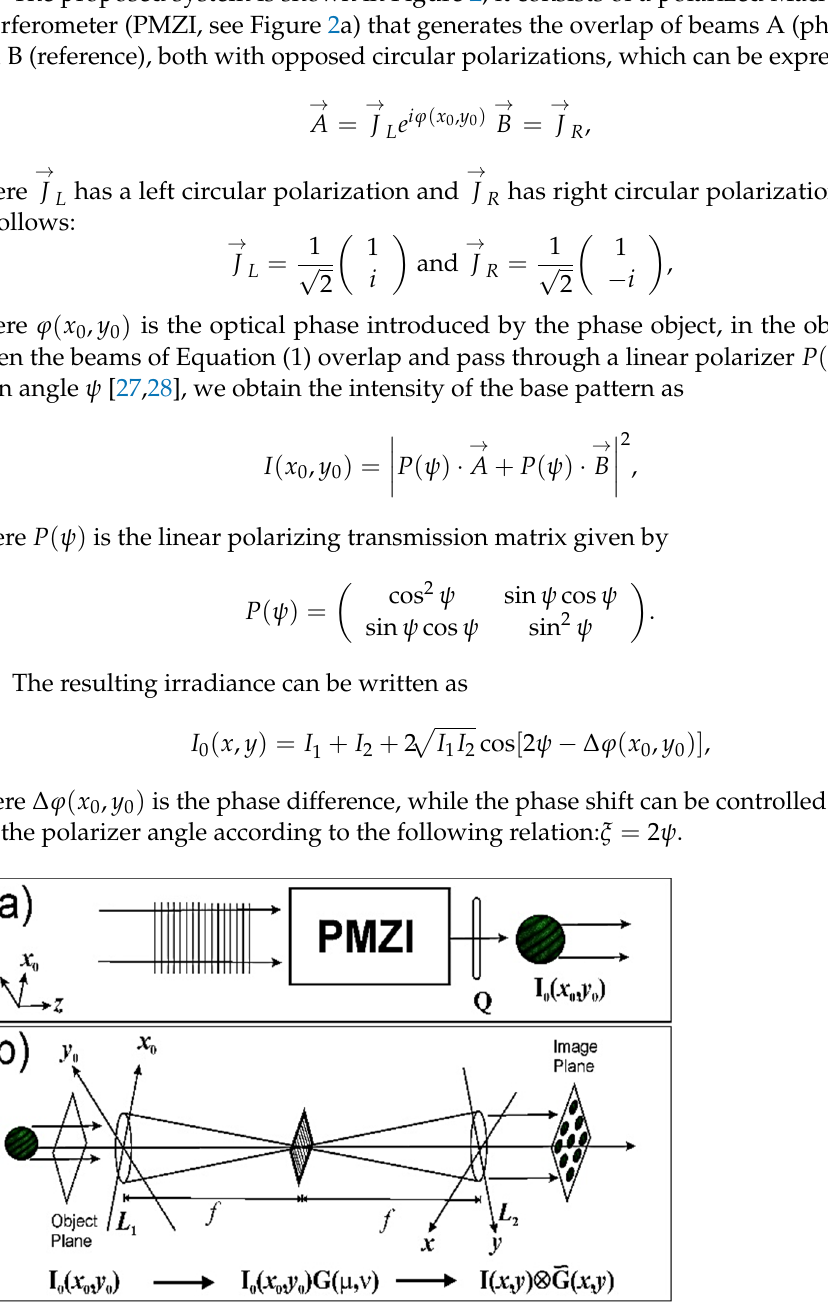
Figure 2. System diagram. ( a ) Pattern generated by the PMZI. ( b ) Replication of the patterns by the 4f diffraction grating system.